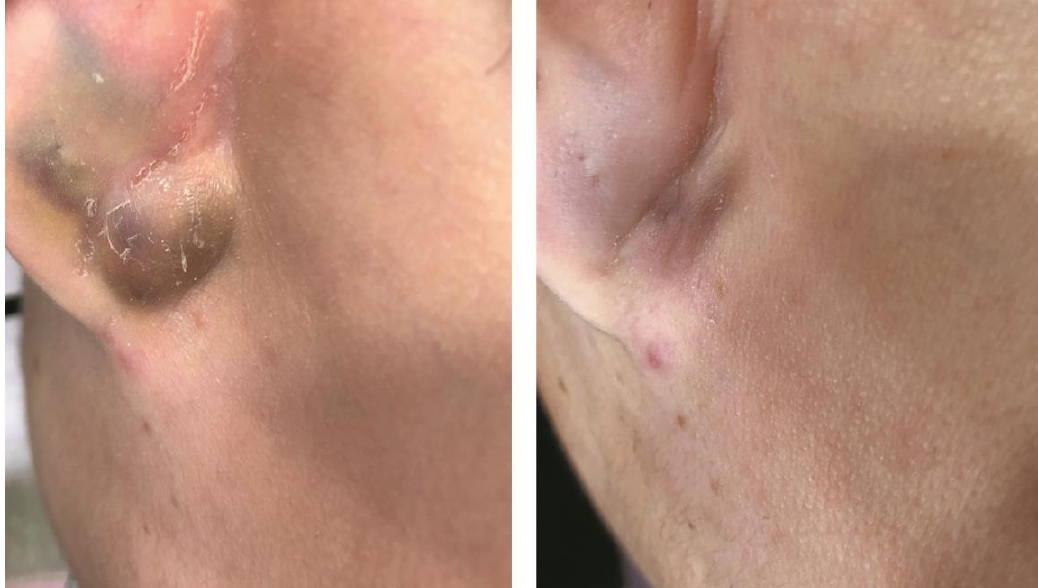
Figure 5. The combined cryotherapy (target temperature at −5 °C, 15 s of spraying) and triamcinolone injection (4.0 mg/mL, 0.2 mL injected intralesionally) yielded a resolution of cystic acne in a 17 year-old Korean male. Before ( left ) and two weeks after combination treatment ( right ). For cryotherapy, a temperature-controlled carbon dioxide spray device (TargetCool; RecensMedical, Ulsan, Korea) was used. Permission and consent were given for the use of the photographs.